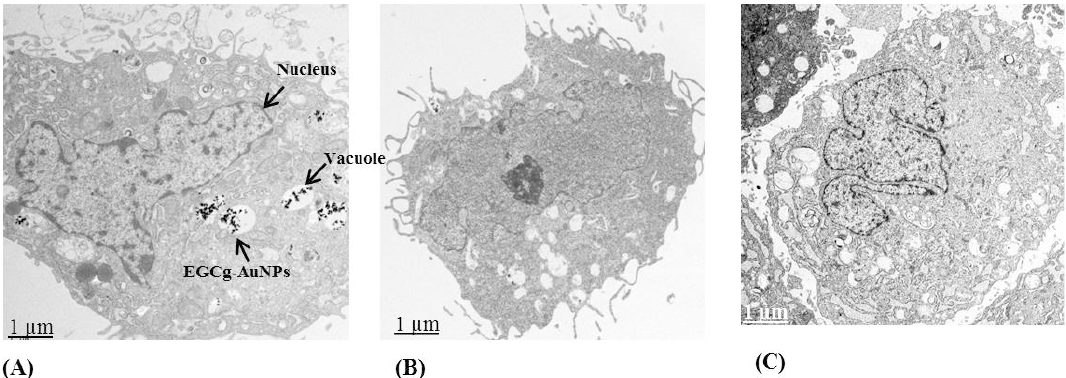
Figure 5. Cellular internalization of gold nanoparticles in HCASMCs : ( A ) cells treated with EGCg-AuNPs (50 μ g/mL), 2 h; ( B ) cells pretreated with laminin receptor blocking antibody (ABLR), then treated with EGCg-AuNPs (50 μ g/mL), 2 h; ( C ) cells treated with starch functionalized gold nanoparticles (50 μ g/mL), 2 h; images were captured by transmission electron microscopy. HCASMCs (human coronary artery smooth muscle cells).